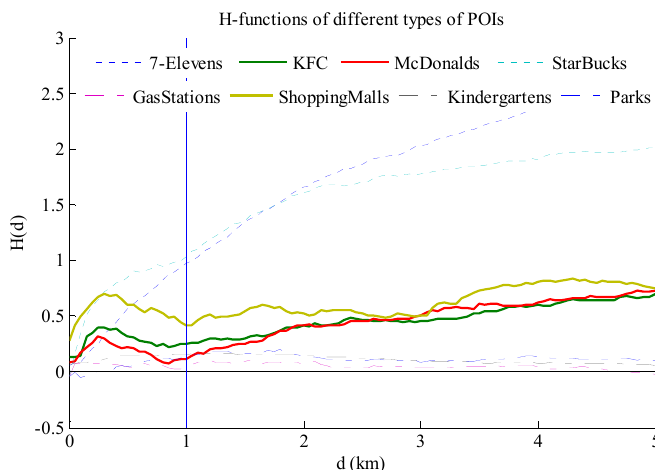
Figure 11. Distribution of different types of POIs in Beijing.